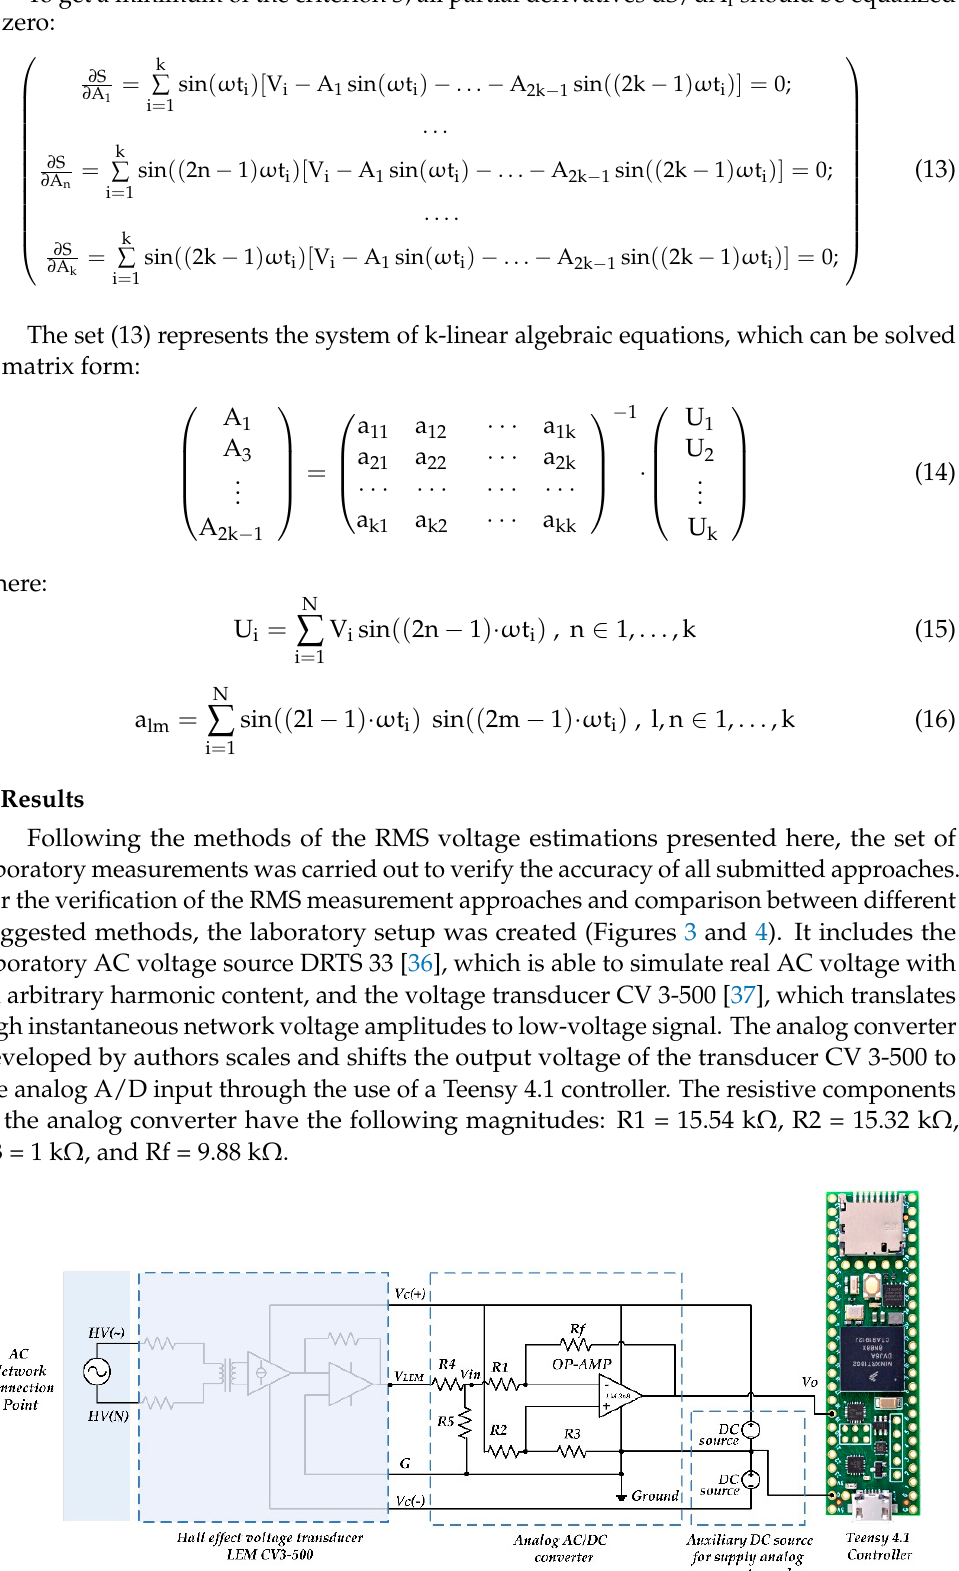
Figure 4. Test-bench for the verification different methods of the RMS estimation: 1—AC voltage source; 2—voltage transducer; 3—computer for data recording. The AC source simulated real voltage signal with a content from the first up to the twenty-fifth odd harmonic. The magnitude of each harmonic was determined by the standard [38]. These are represented in Table 2. Table 2. Relative magnitudes of harmonics in a signal modeling real voltage signal. % of the Full Voltage U 1